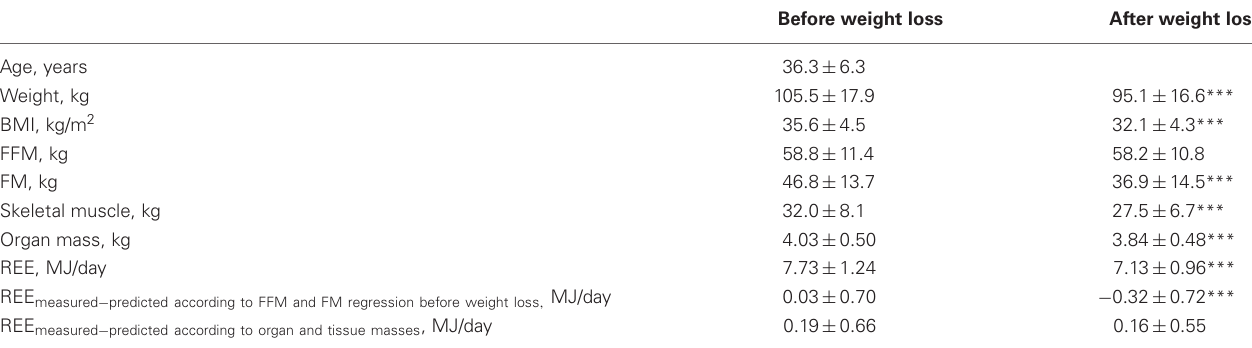
Table 4 | Comparison of body composition and resting energy expenditure between baseline and after weight loss ( n = 47 males and females, study population 2 with organ-tissue